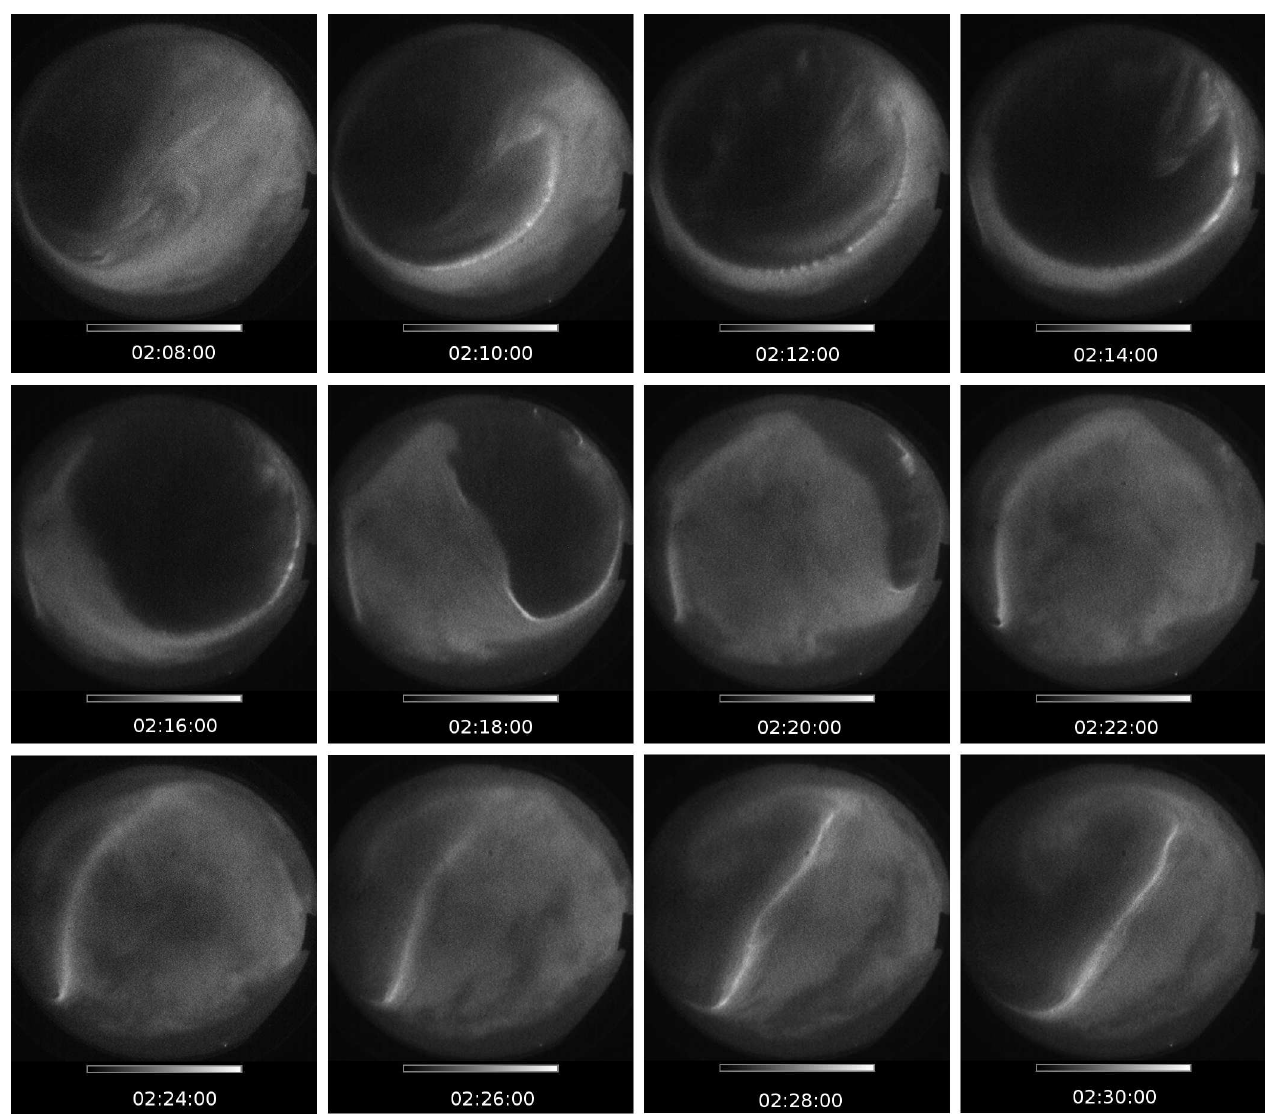
Fig. 5. Series of all-sky camera images taken at Kilpisj ¨ arvi showing the propagation of the omega-band directly over the station. Images are shown for every 2min during the intervall 02:08–02:30UT. Image orientation is such that North is up and East is right. 5 Electrodynamics of an